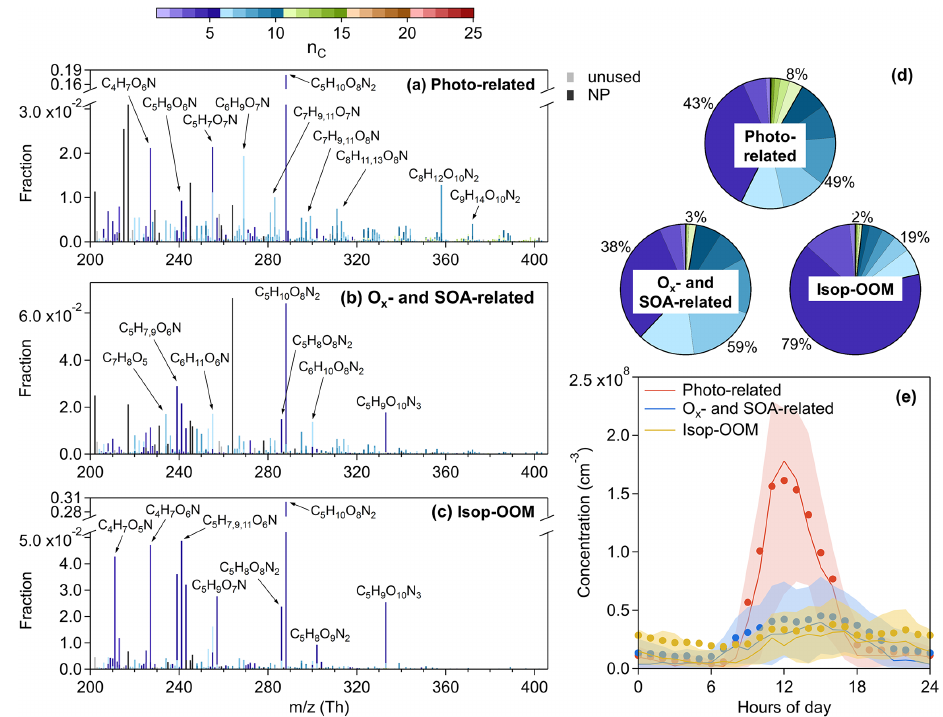
Figure 7. Mass spectra of (a) the Photo-related factor, (b) the O x - and SOA-related factor, and (c) the Isop-OOM factor, and the elemental formulas of major peaks are labeled above them. Peaks are color-coded by n C as indicated at the top of the figure, and the fractions of peaks grouped by n C are reported in (d) the pie charts. The gray bars are fluorinated contaminations or non-identified compounds. The nitrated phenols are drawn separately with black peaks in (a) – (c) . The molecules represented by the gray and black bars were not included in (d) . Diurnal patterns of the three factors are shown in (e) : the bold solid lines are the median values; shaded areas represent percentiles of 75% and 25%; and solid circles represent mean